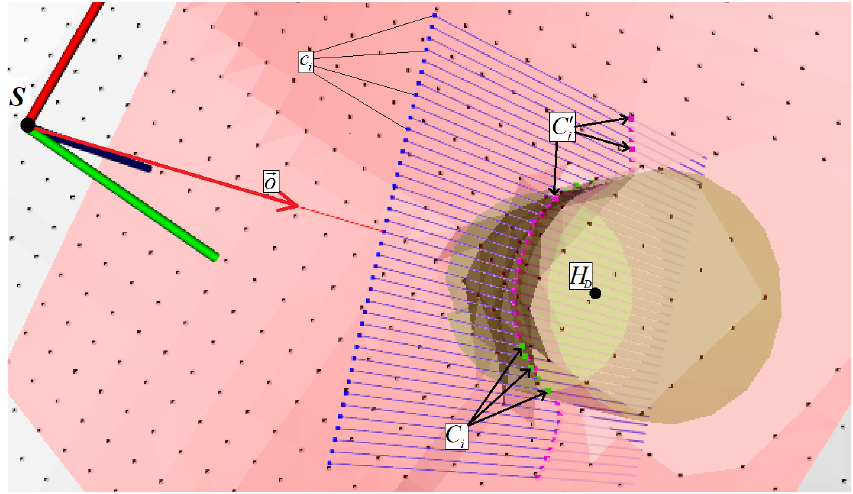
Figure 4. General view of the trajectory, projection vectors and triangulation surfaces.